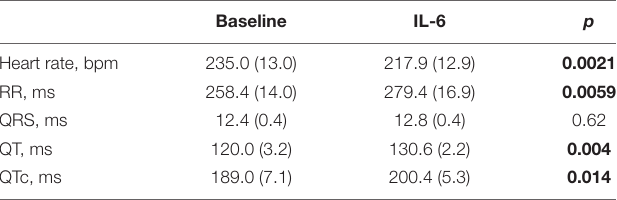
FIGURE 3 | Impact of IL-6 on QTc in guinea pigs. (A) Representative lead-II ECG from a guinea pig during the basal condition (a) with a normal sinus rhythm at 250 beats/min with a QTc = 219 ms, and (b) at 40 min after intravenous injection with IL-6 (184 µ g/kg) in the same guinea pig, demonstrating a sinus rhythm at 227 beats/min with a QTc = 232 ms; the shaded area in light blue and the black arrows indicate the QT interval at baseline, while the red arrows indicate the QT interval after IL-6. (B) Changes in QTc levels at baseline and 40 min after IL-6 injection for each guinea pig ( n = 5); two-tailed paired t -test, * p < 0.05. (C) Changes in QRS interval observed at baseline and 40 min after IL-6 injection for each guinea pig ( n = 5); two-tailed Wilcoxon matched pairs test, n.s. not significant.